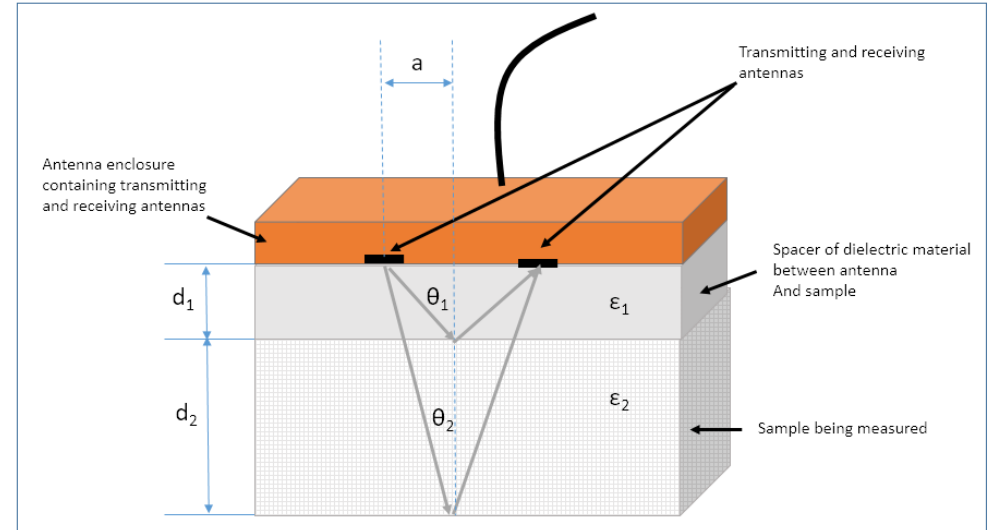
Figure 15. Geometry and known parameters used to calculate unknown ε 2 via the straight ray path assumption.